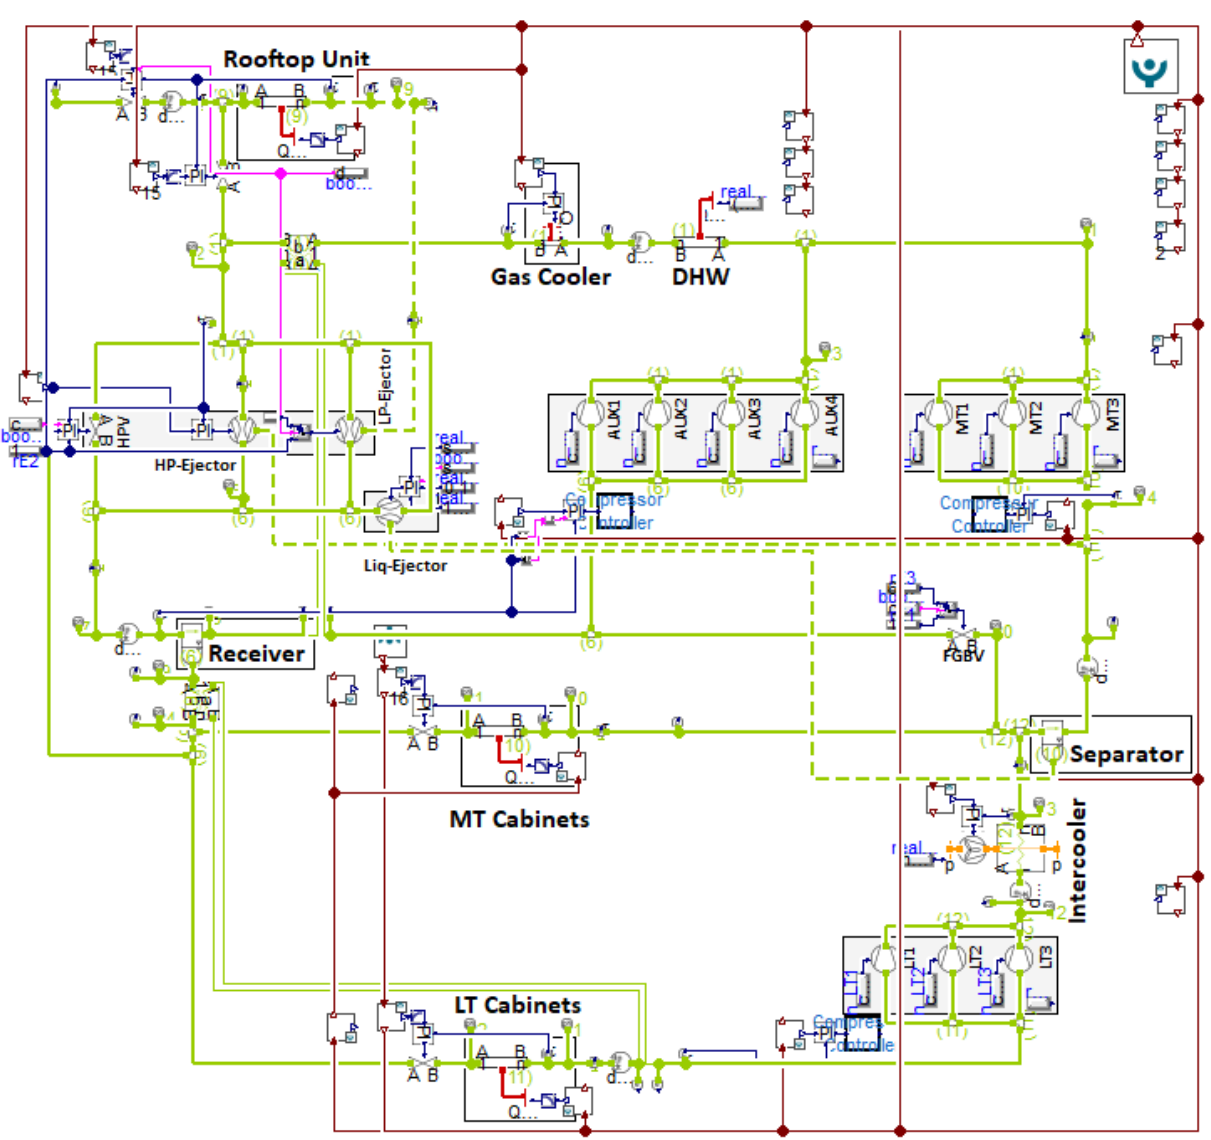
Figure 2. Layout of the Modelica model depicting the combined heating and cooling package of the Porto de Mos plant.